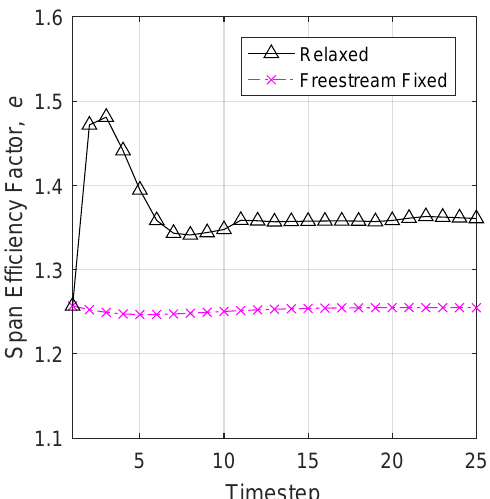
Figure 12. Convergence of the span efficiency factor as the number of time steps increases during an analysis of the NASA Trap Wing LaRC Configuration